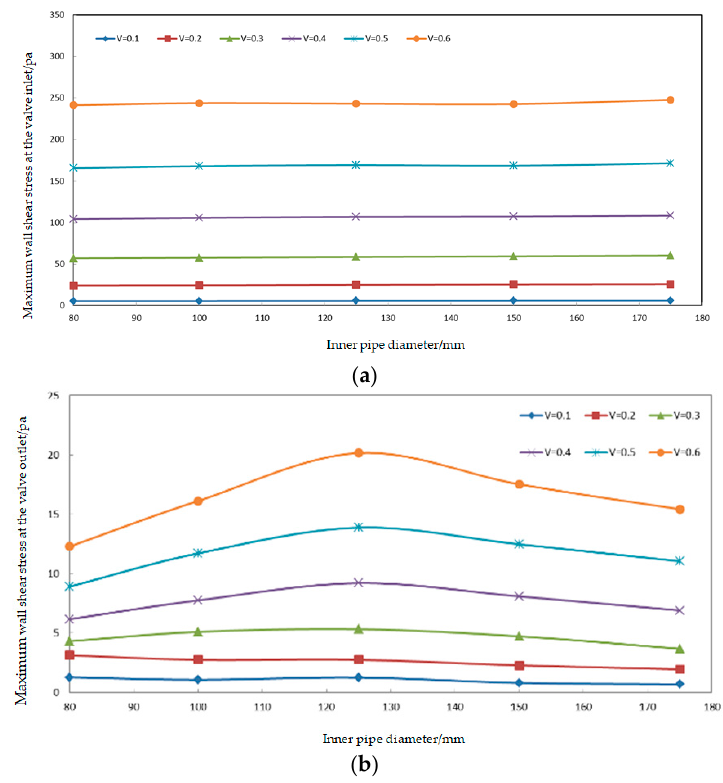
Figure 23. The influence of inner pipe on the erosion of the valve; ( a ) Trend of maximum wall shear stress at the valve inlet; ( b ) Trend of maximum wall shear stress at the valve